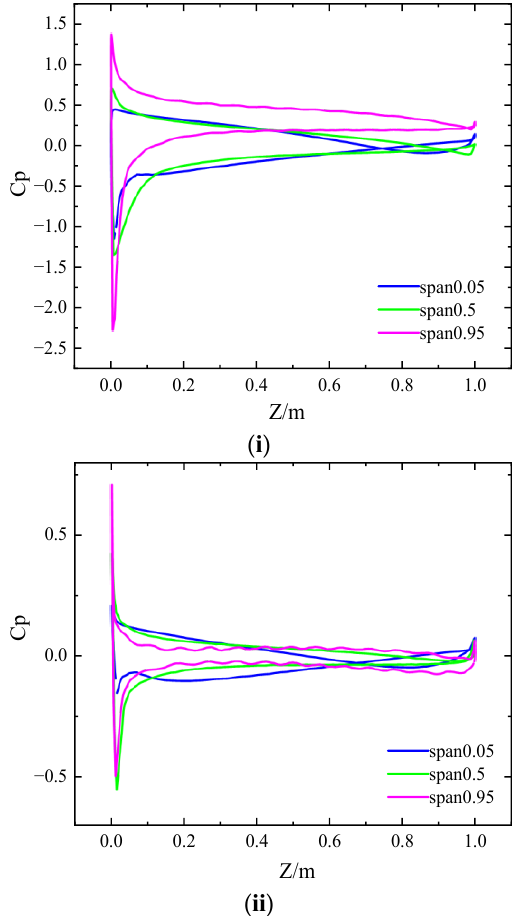
Figure 15 . Pressure coefficient diagram under turbine conditions. ( ⅰ ) 0.6Q. ( ⅱ )